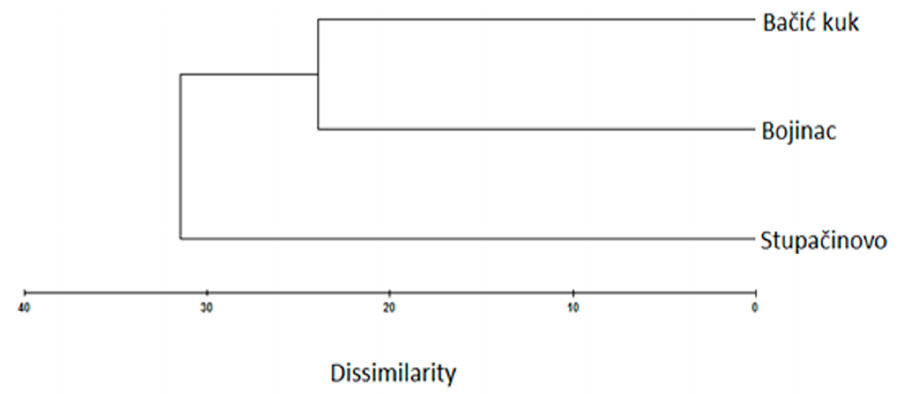
Figure 1. PCA of essential oil (EO) components in Micromeria croatica from the localities Bojinac (Boj), Ba č i ć kuk (Bk) and Stupa č inovo (St). EO components identified in M. croatica from Boj and Bk; EO components identified in M. croatica from Boj and St; EO components identified in M. croatica from St; EO components identified in M. croatica from St and Bk.